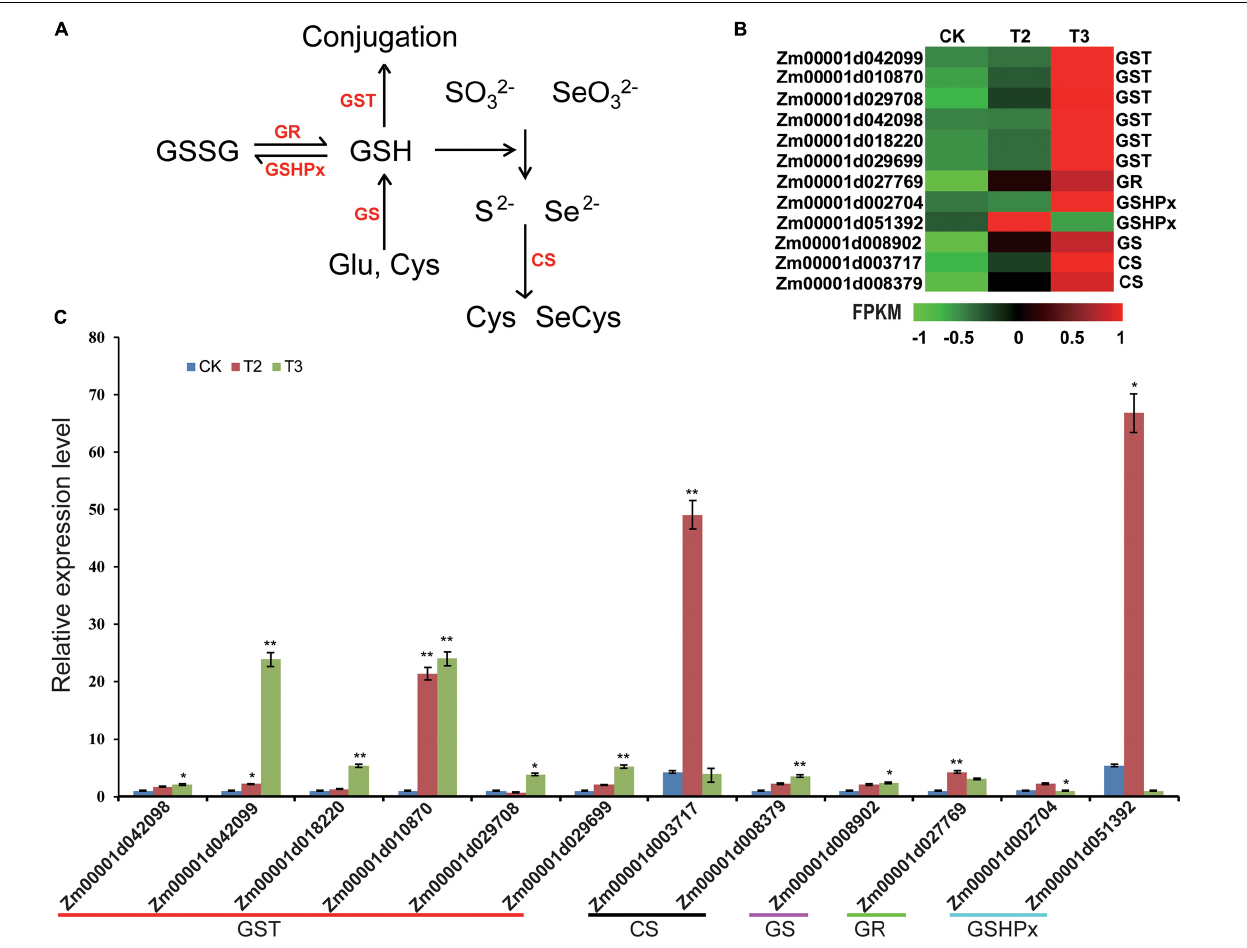
FIGURE 5 | Expression profiles of DEGs involved in the transformation of inorganic Se into organic Se and glutathione (GSH) metabolism. (A) GSH and Se (S) metabolism process. Arrows represent the activation processes. GSSG, glutathione disulfide; GSH, glutathione; GR, glutathione reductase; GSHPx, glutathione peroxidase; GST, glutathione S-transferase; GS, glutathione synthetase; and CS, cysteine synthase. (B) The heatmap was constructed using the FPKM. For the heatmaps, the color from green to red represents low to high expression levels. (C) DEGs involved in GSH and Se (S) metabolism process are verified by qRT-PCR. The statistical significance was determined using SPSS 16.0 with a one-way analysis of Tukey’s test. * represents p ≤ 0.05; ** represents p < 0.01. The x-axis represents Se application treatments (CK, T2, and T3), and the y-axis indicates the relative expression levels. Error bar shows the SEs of three biological